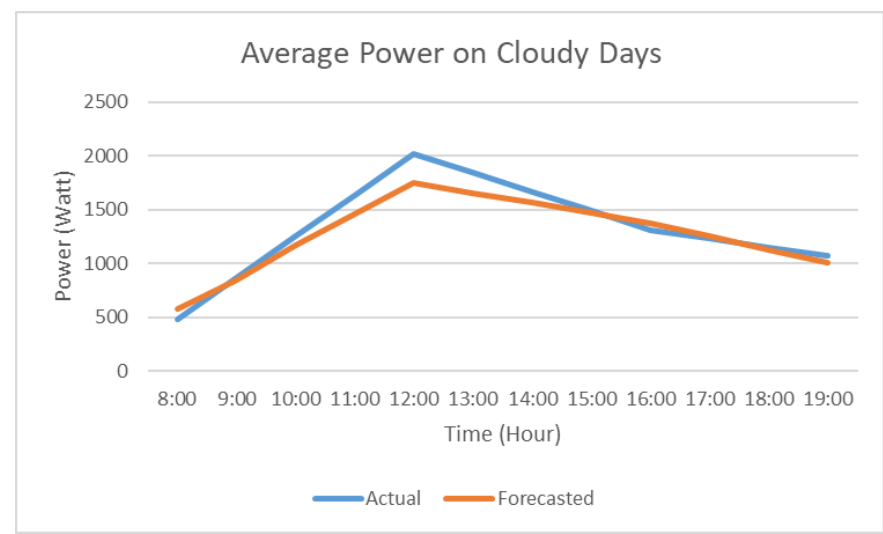
Figure 9. Actual versus forecasted curve of average solar power for WT-ANFIS-HFPSO on cloudy days.